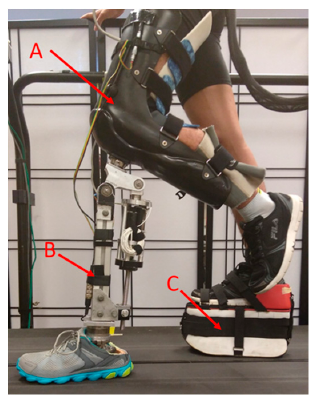
Figure 1. An able-bodied subject wearing the powered prosthetic leg. A was an abled-bodied adaptor, B was the powered prosthetic leg, and C was a foot raiser, which was used to ensure the length of the prosthetic leg and the unaffected leg was the same.